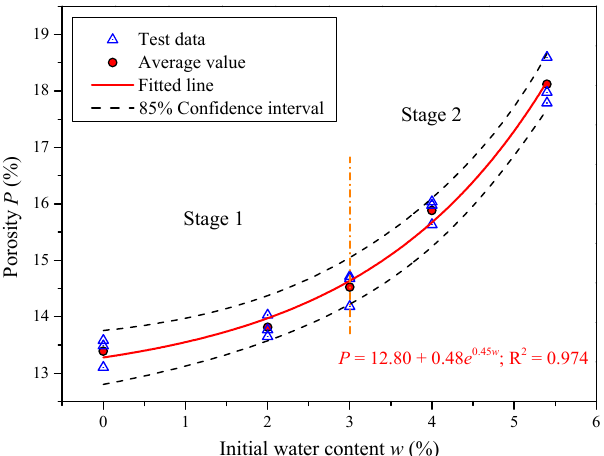
Figure 12. Porosity evolution of microwave irradiated sandstone with different water content.